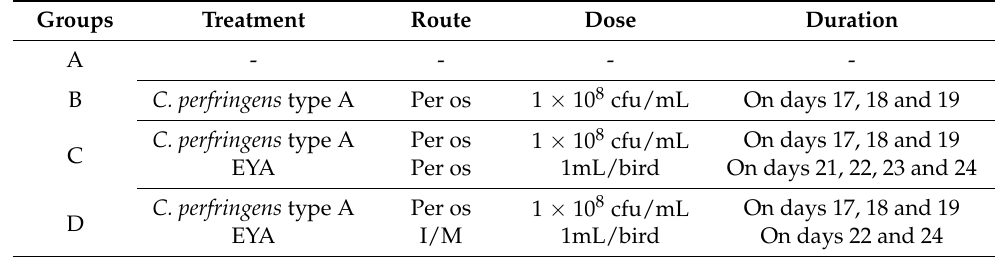
Table 1. Design and infection of the experimental birds. Groups